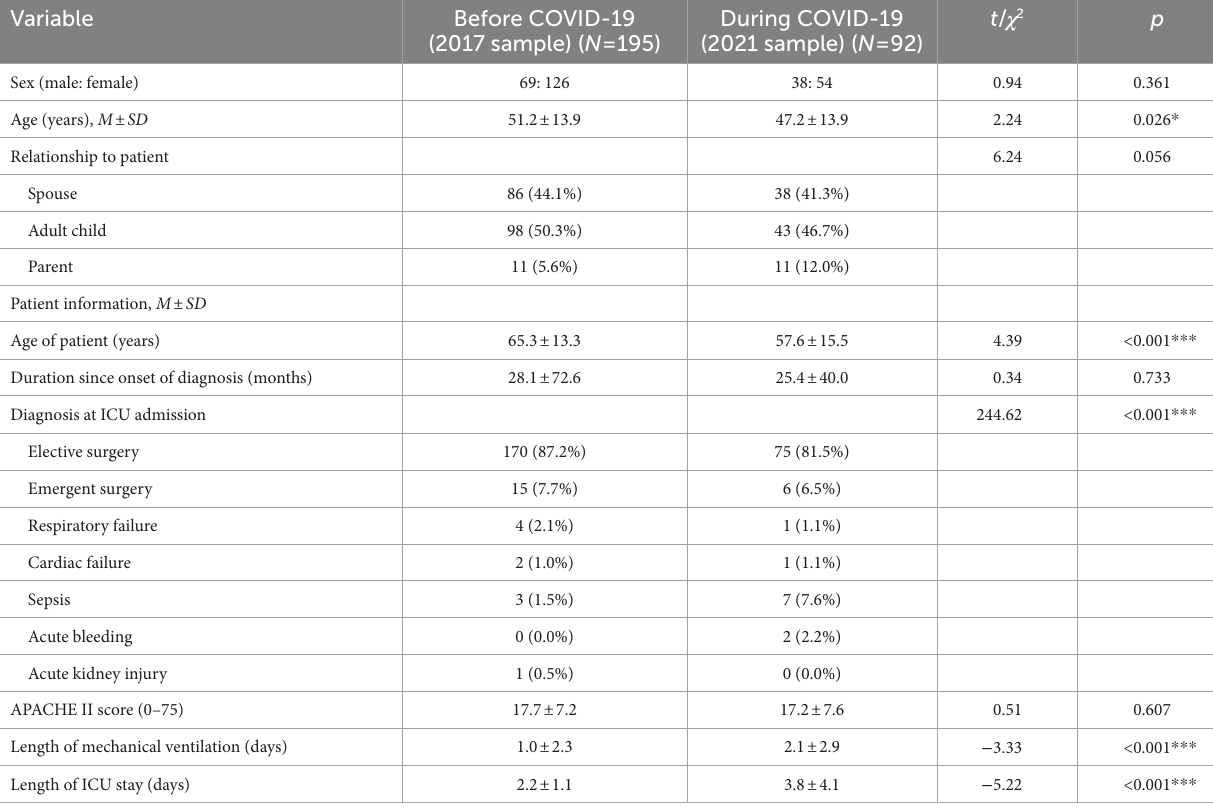
TABLE 1 Participants’ demographic information.